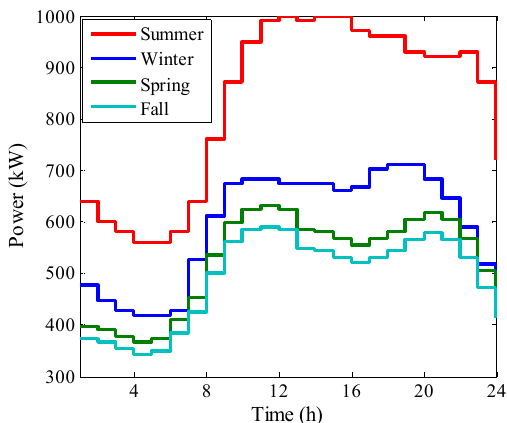
Figure 2. The typical daily load curves of four seasons.